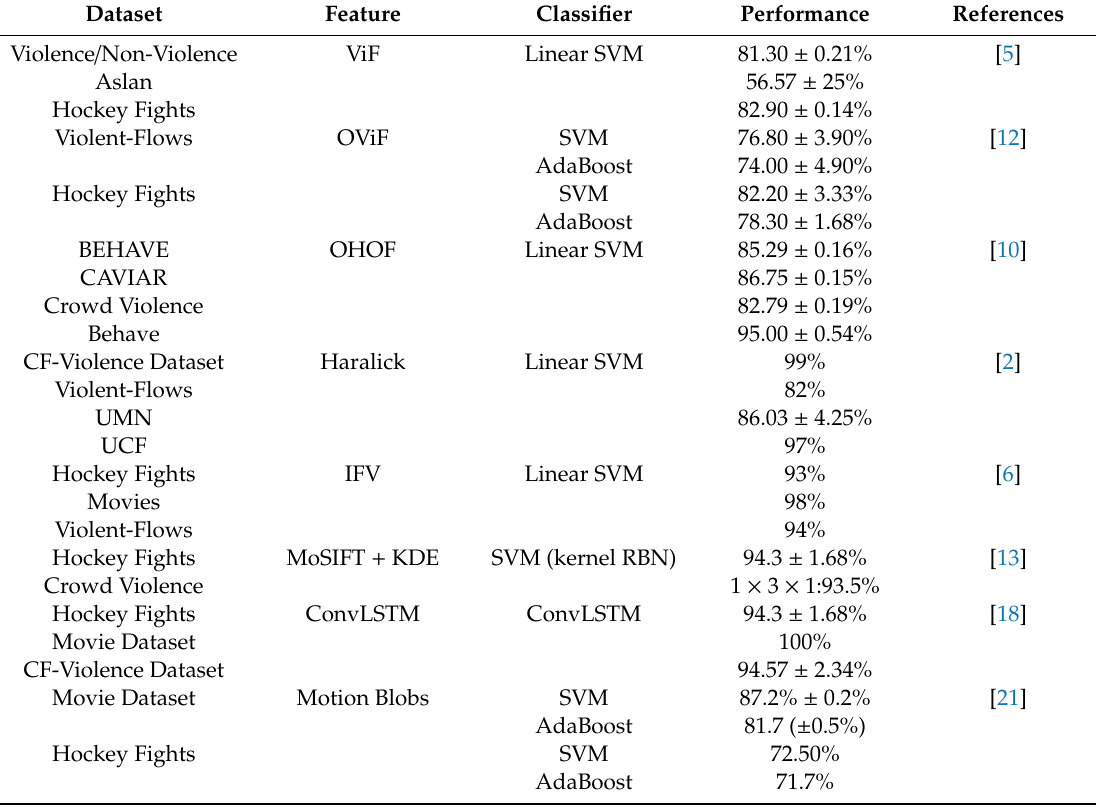
Table 3. Summary table of the reviewed techniques’